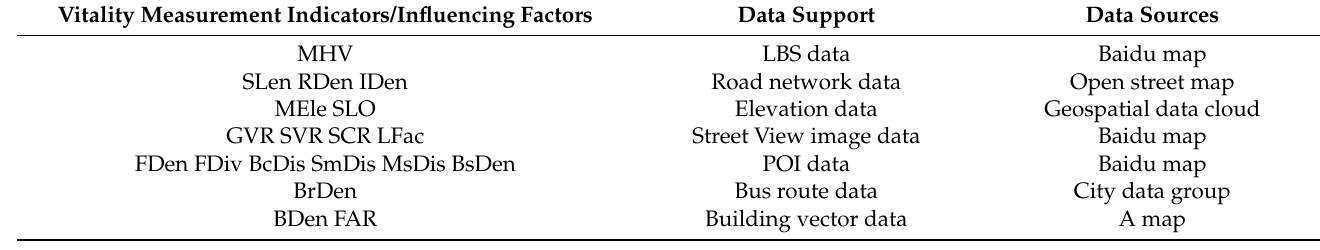
Table 3. Required data for street vitality research.